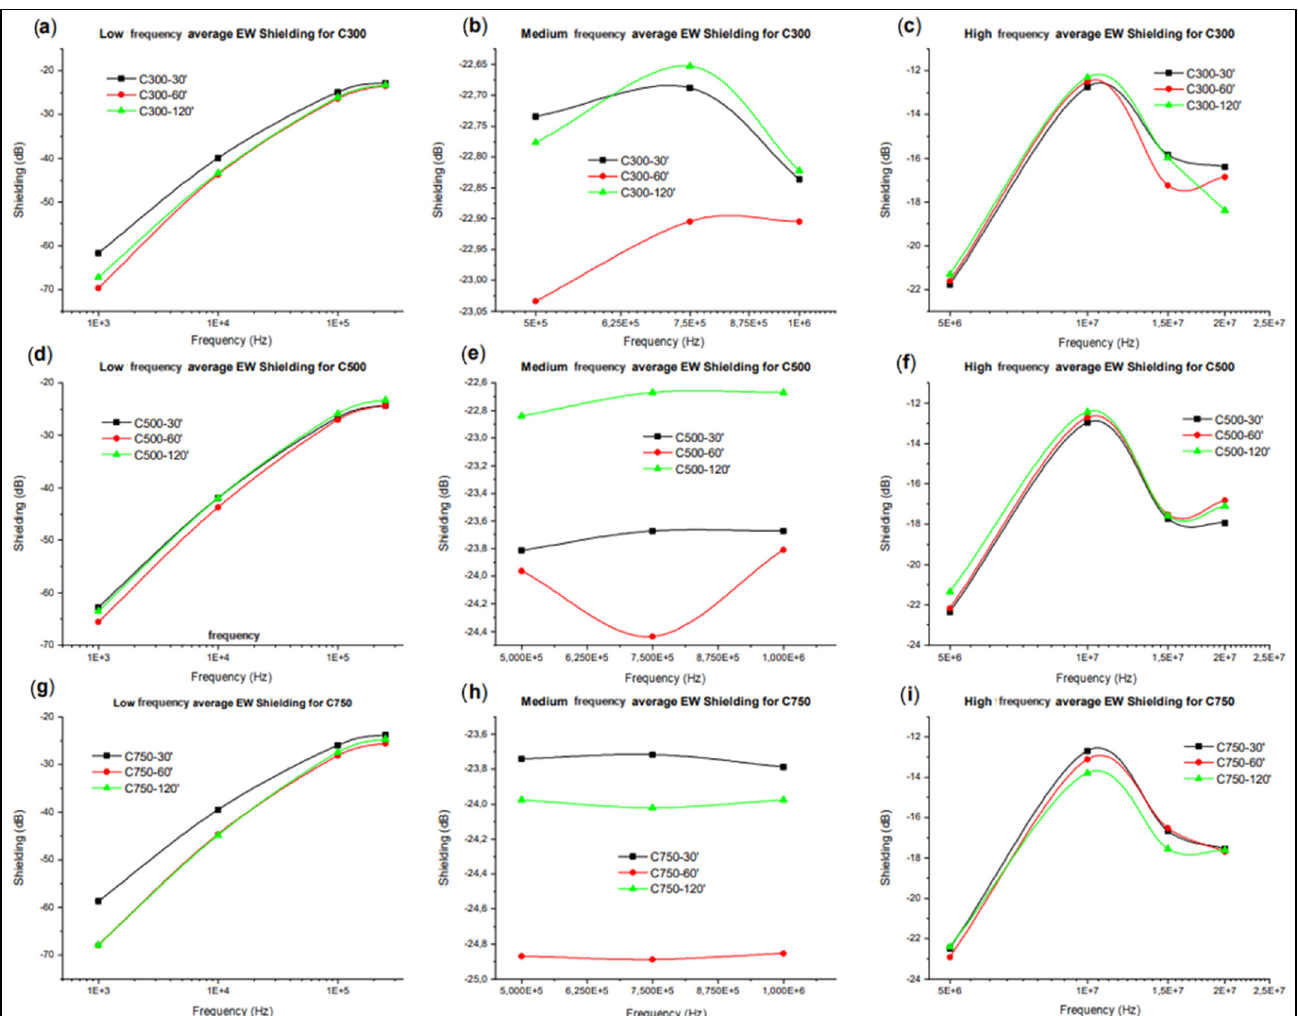
Figure 17. Average value of electrical signal shielding according to sonication time for systems with C300 in the low ( a ), medium ( b ), and high ( c ) frequency band; with C500 in the low ( d ), medium ( e ), and high ( f ) frequency band; and with C750 in the low ( g ), medium ( h ), and high ( i ) frequency band.